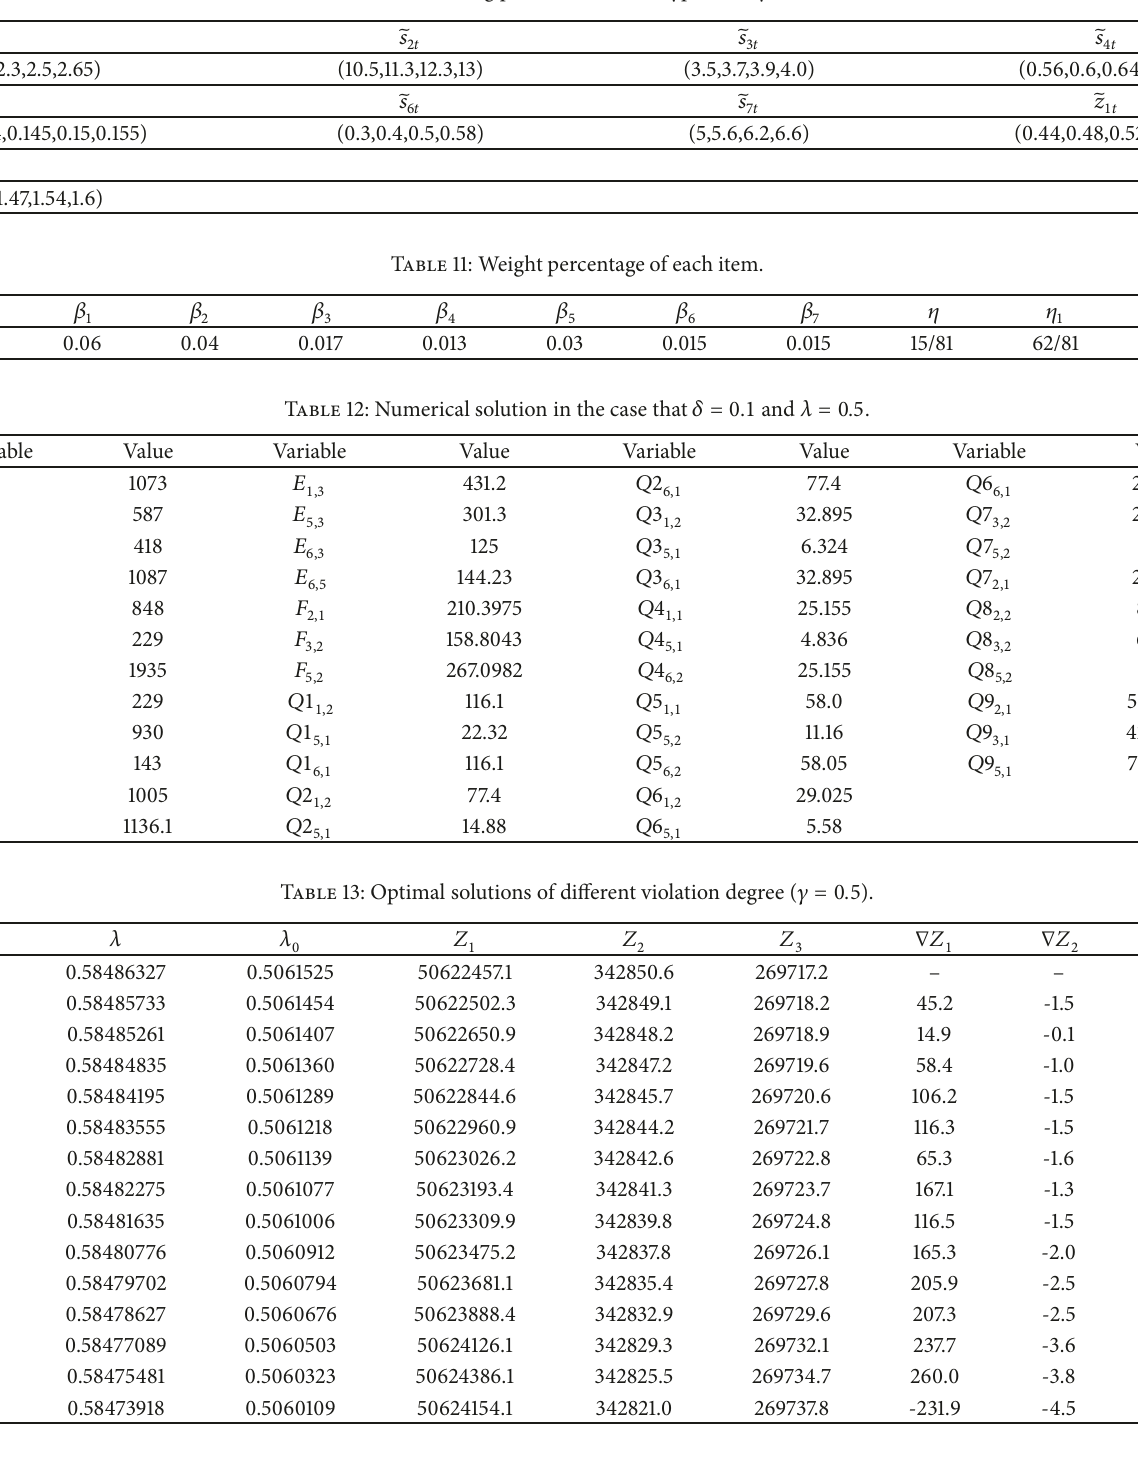
Table 10: Unit selling price of each item type ( ×10 3 yuan/ton).